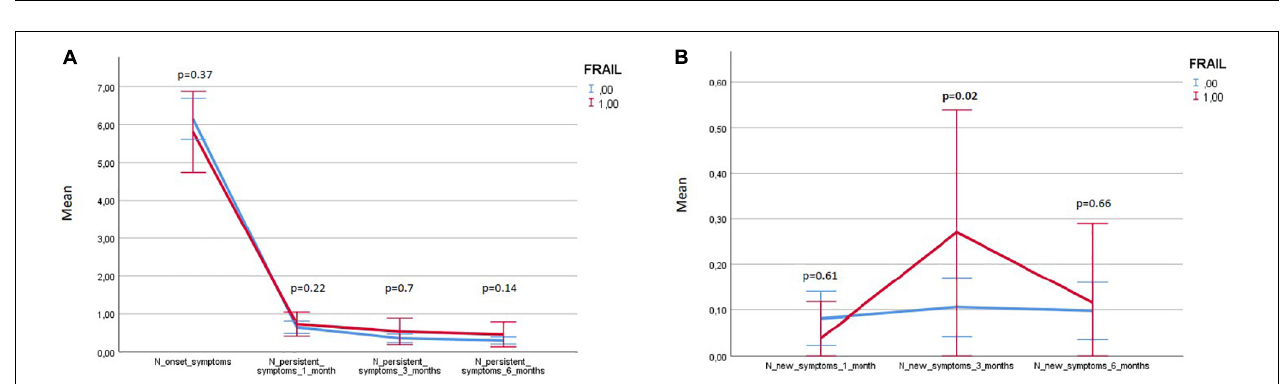
FIGURE 4 | (A,B) Onset of symptoms in frail and robust